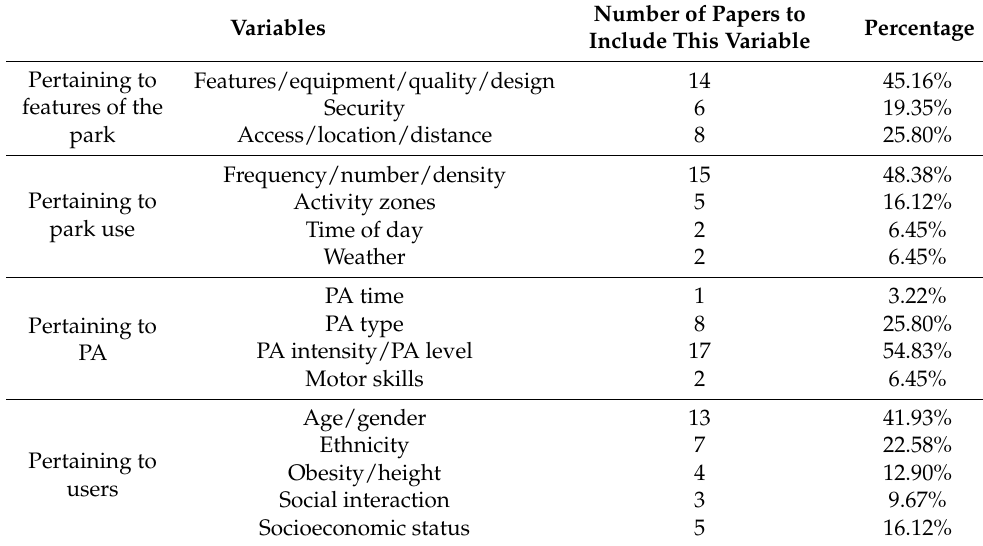
Table 5. Variables examined in the considered research